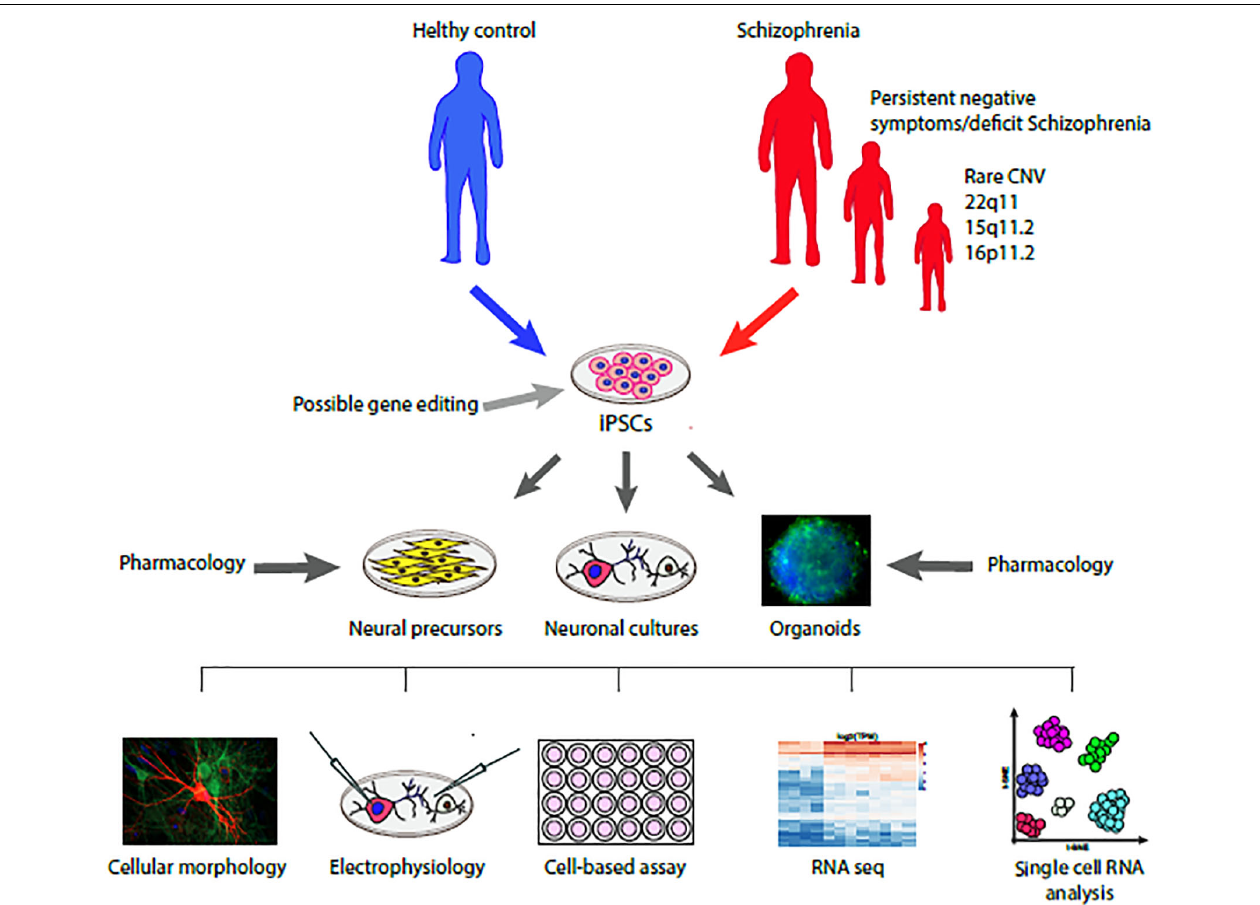
FIGURE 1 | Schematic representation of the translational model to study the cellular and molecular phenotype of iPSC derived neurons from donors with schizophrenia compared with healthy controls and their response to pharmacological agents. Further evolution of this working model will include a precision medicine approach driven by patient stratification based on specific clinical descriptors (e.g., negative symptoms) or genetic liabilities (e.g., rare CNVs) associated to possible gene editing